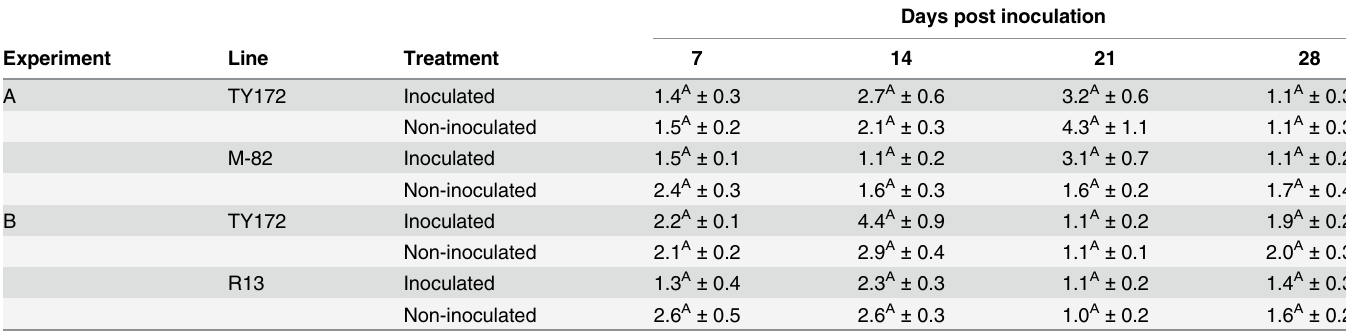
Table 1. Average relative transcript levels of the Pelo gene in resistant TY172 and susceptible M-82 and R13 plants.